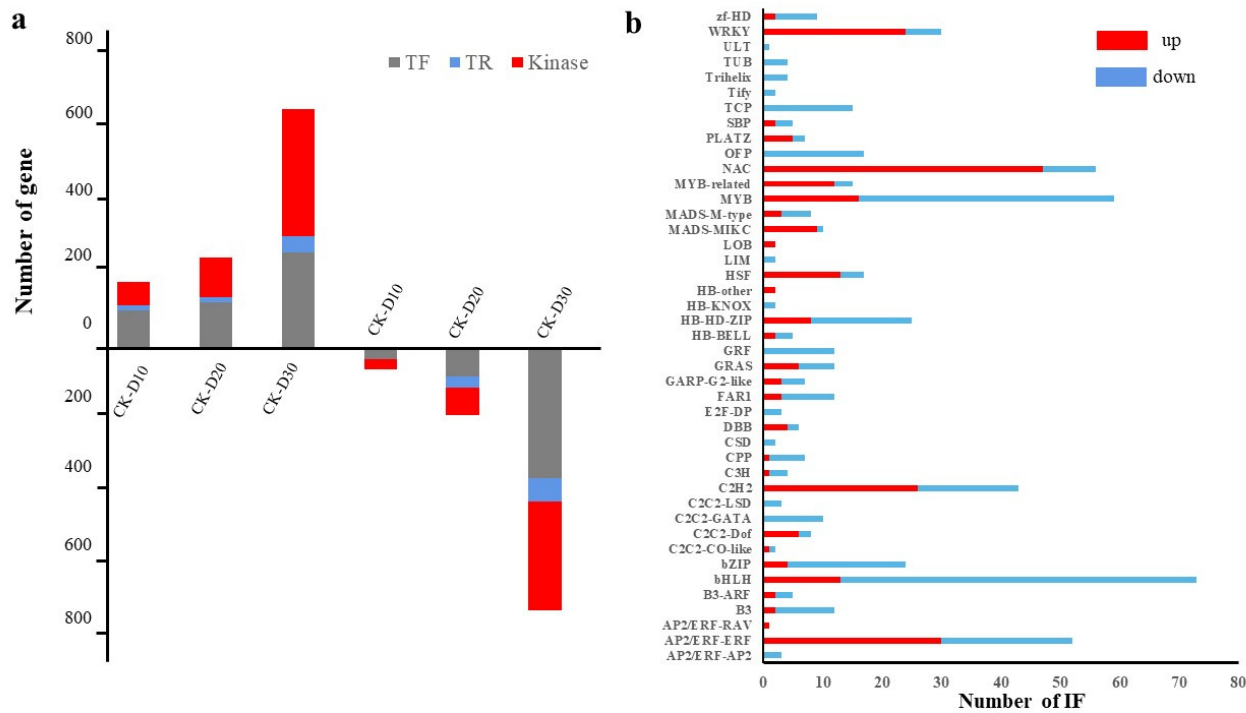
Figure 3. Distribution of transcription factors in DEGs. ( a ) Column diagram of the number of TFs, TR, and kinase in DEGs in different sample pairs. The first three columns represent up-regulated expression, and the last three columns represent down-regulated expression. ( b ) Column diagram of classi fi cation of the di ff erentially expressed TFs.